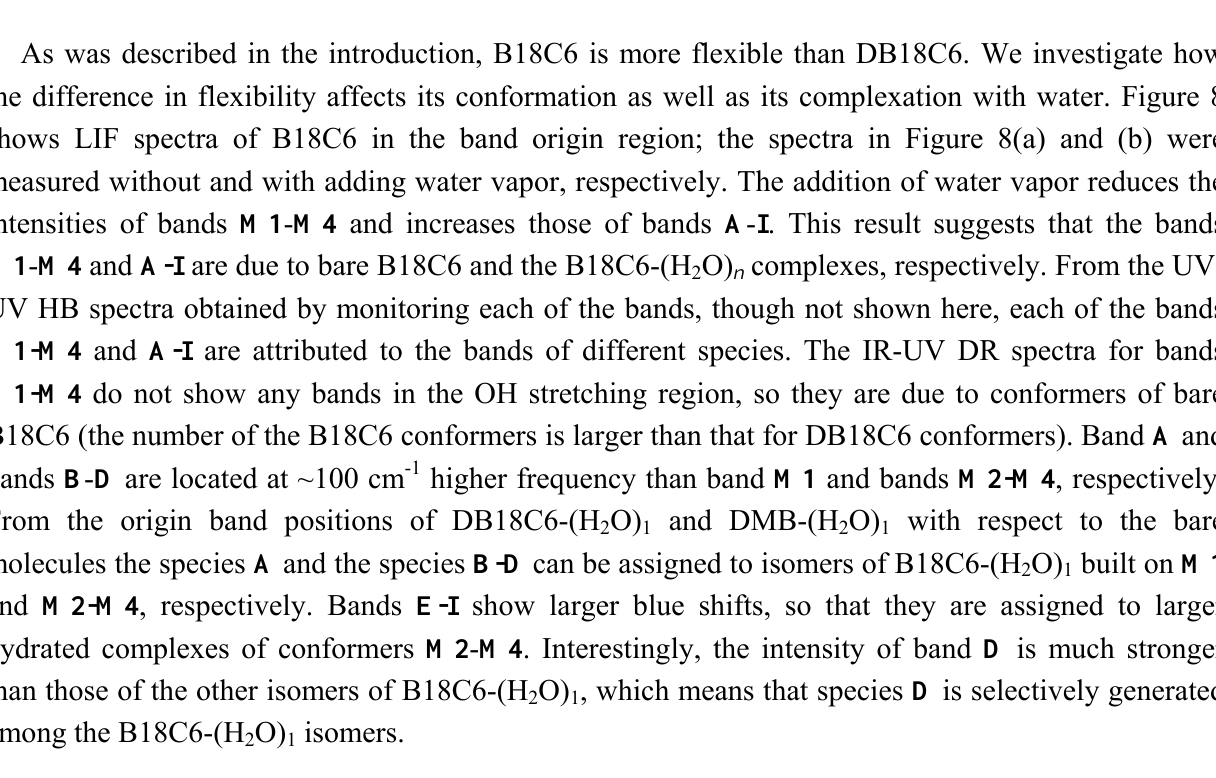
Figure 8. LIF spectra of jet-cooled B18C6 and its hydrated complexes obtained (a) without and (b) with adding water vapor. Figure adapted from Reference